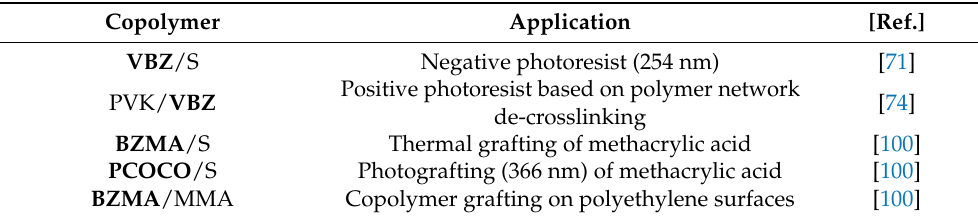
Table 4. Some examples of applications of photoperoxidation of pendant copolymer BZ